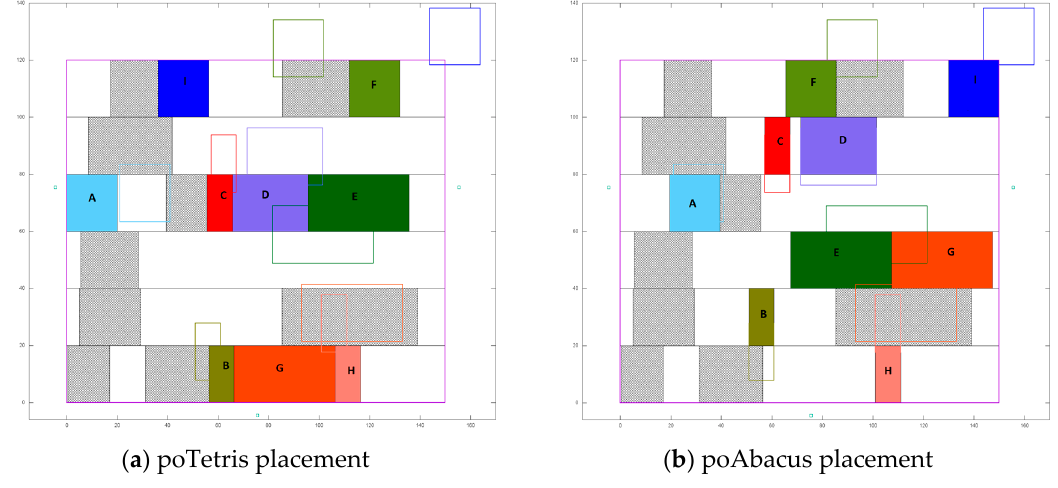
Figure 2. Obstacle-aware placement examples